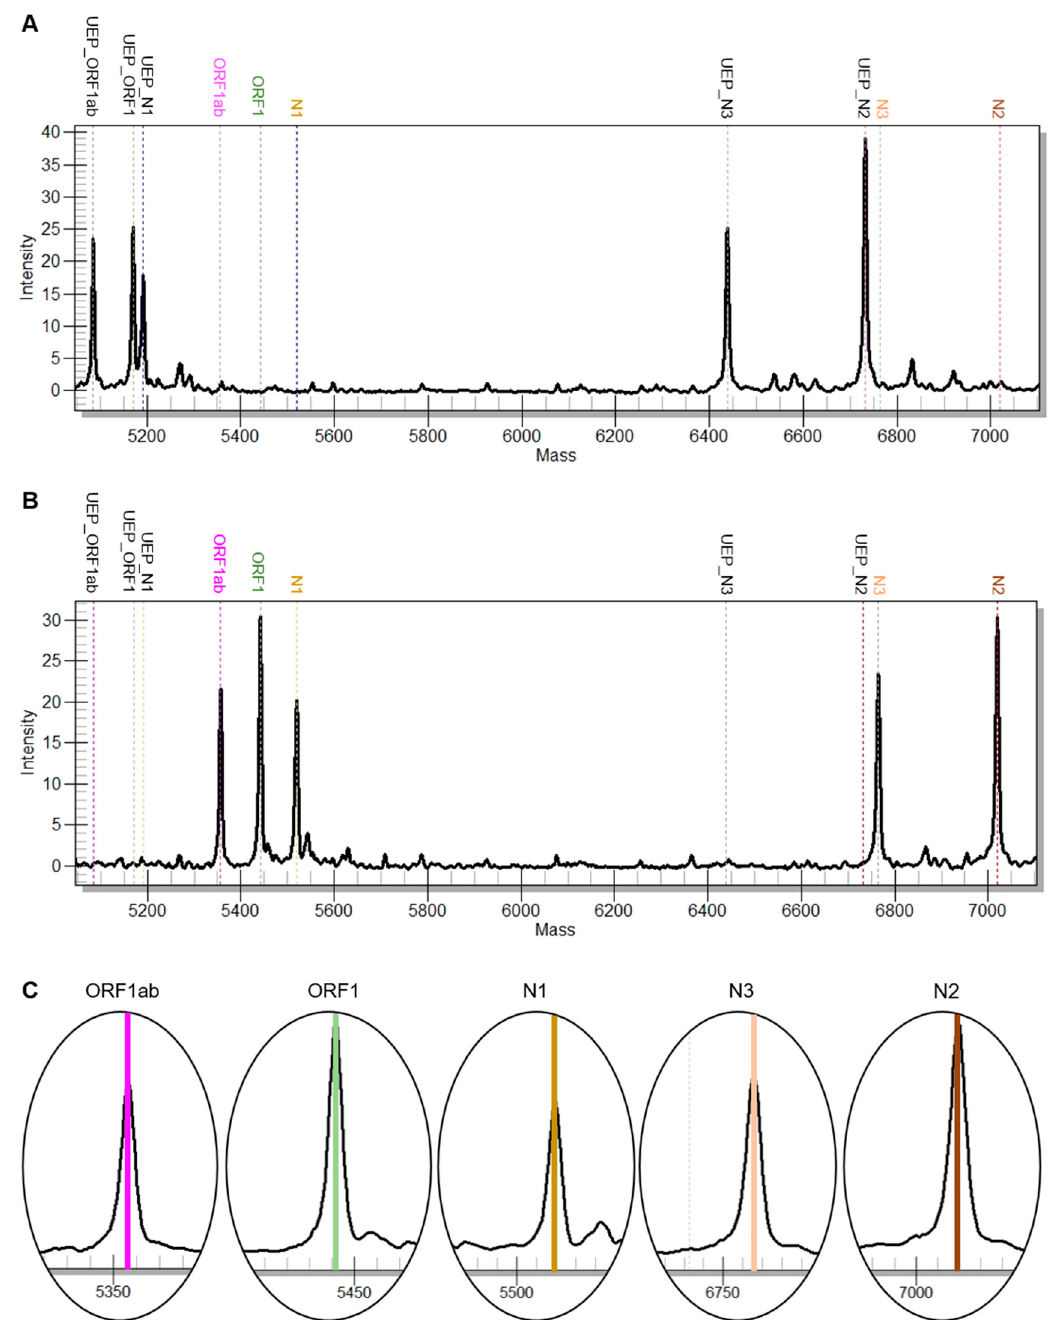
Figure 2. Examples for a positive and negative result of the commercial MS assay. In the sum spectra ( A , B ) the expected mass peaks for the respective amplicons are highlighted with a dashed line. In the negative case ( A , ID 17) peaks of unextended primers are observed (UEP). In the positive case ( B , ID 5) peaks for amplicons of the ORF1ab, ORF1, N1, N2 and N3 can be identified. Zoomed spectra of these amplicons are depicted in ( C ).